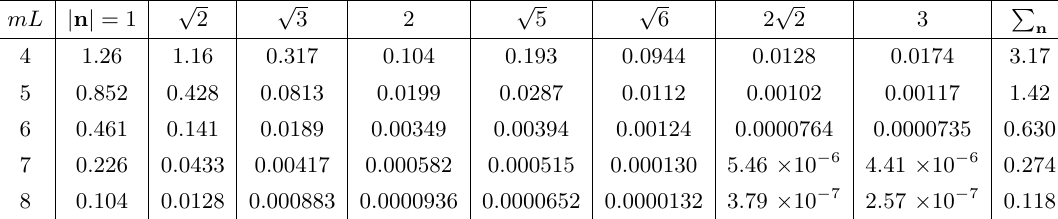
Table 2 . Numerical estimates of the pole contributions to (cid:1) a s ( L ), normalized to a HVP,LO 700 (cid:2) 10 (cid:0) 10 for various (cid:12)xed values of j n j , corresponding to contributions scaling as e (cid:0)j n j mL .